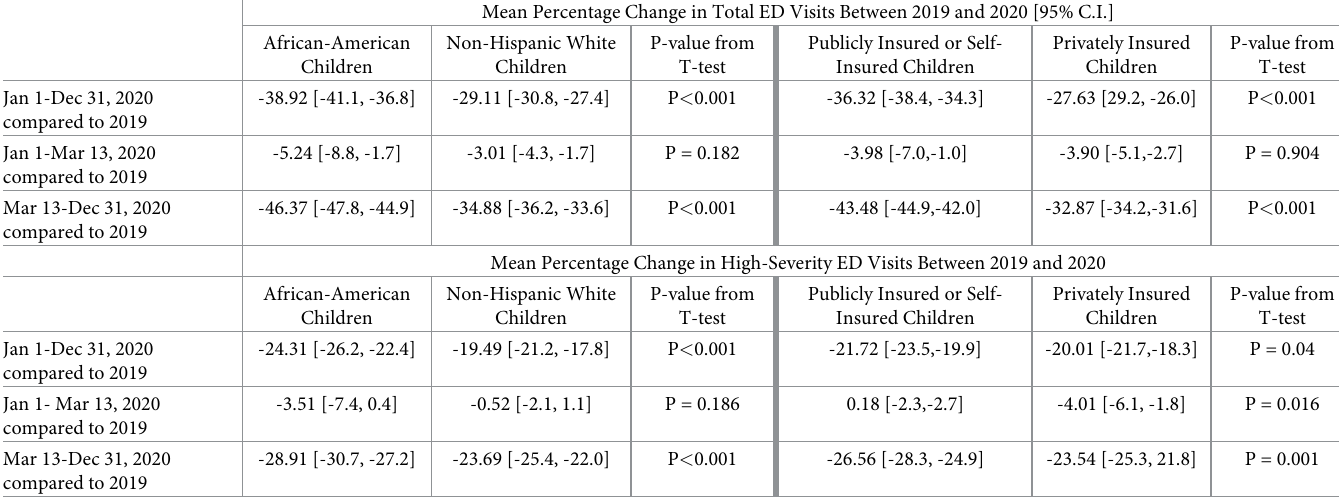
Table 2. Differences in the mean date-specific percentage changes in 2020 compared to 2019 for total and high-severity ED visit counts by race and insurance status. Mean Percentage Change in Total ED Visits Between 2019 and 2020 [95%